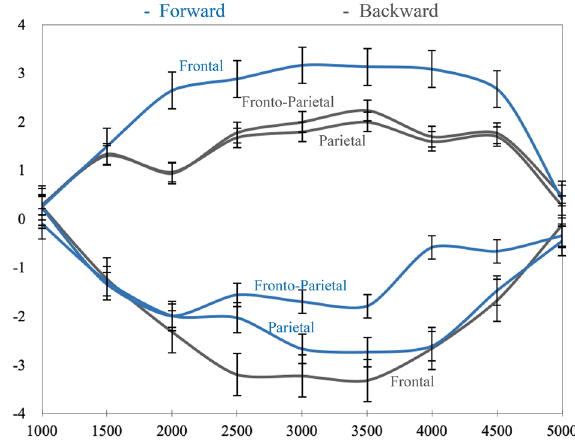
Figure 6. Temporal evolution of beta-frequency (13.5–30 Hz) over 5 s time period across the three ROI’s for forward and backward mental imagery (i.e. sagittal axis). X axis represents the time-course of 5 s in milliseconds based on a time-window of 1000 ms; Y axis illustrates the average power spectrum of the neural activity (μV 2 / Hz). Blue colour depicts "forward motor imagery"; grey colour illustrates "backward motor